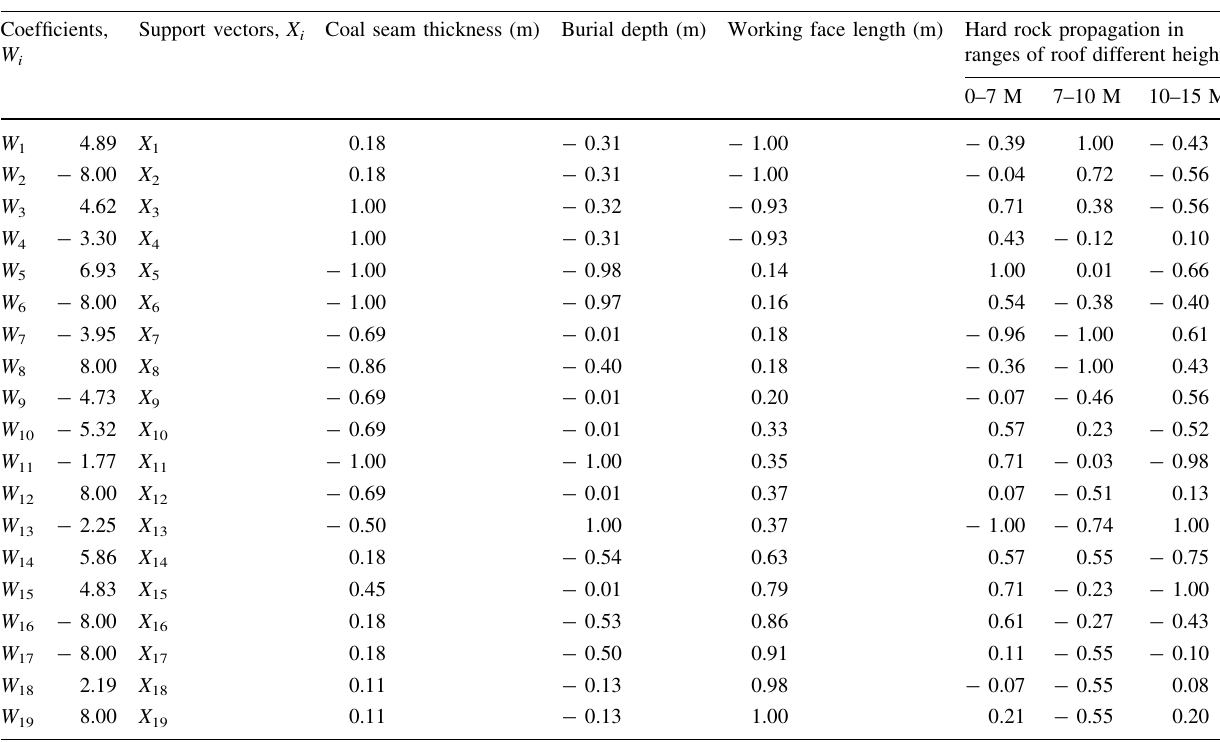
Table 2 Support vectors and their coefficients Coefficients, W